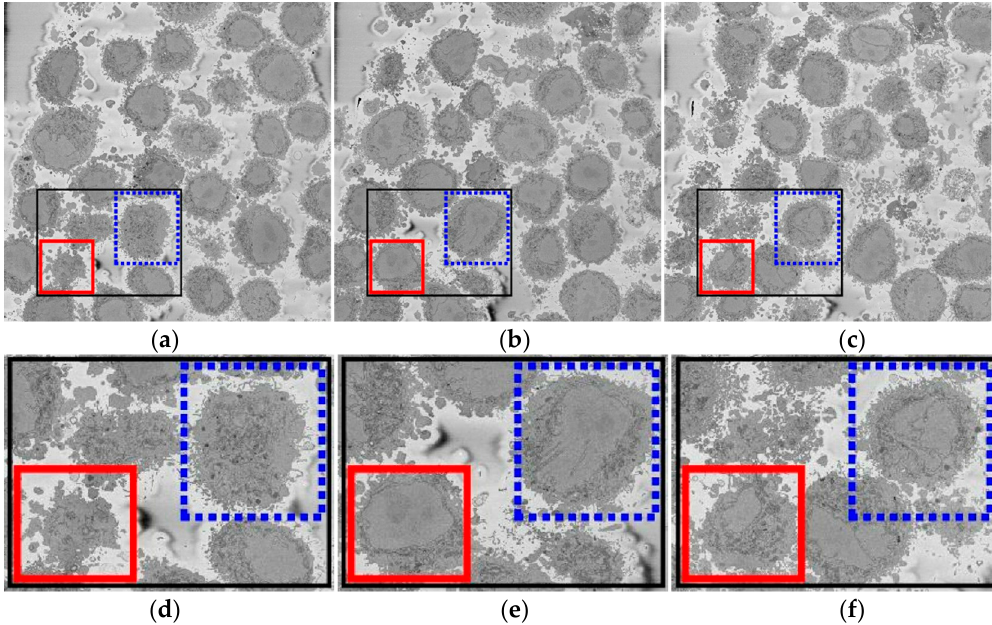
Figure 1. Three representative slices of a three-dimensional (3D) image stack acquired by Serial Block Face Scanning Electron Microscope (SBF SEM) containing numerous HeLa cells. Boxes indicate two regions of interest (ROIs), which contain two of the cells that will be posteriorly segmented. ( a ) A slice on the lower section of the stack; slice 43 of 300. ( b ) A slice on the central section; 118/300. ( c ) A slice on the higher section; 241/300. Black box denotes the ROI that is magnified in ( d–f ). Notice the differences in sizes of cell and nuclei in the images. In particular, the nuclei are hardly visible in ( a ), largest in ( b ), and in ( c ) the nucleus in the blue dotted box appears as several disjoint regions surrounded by a darker nuclear envelope (NE).